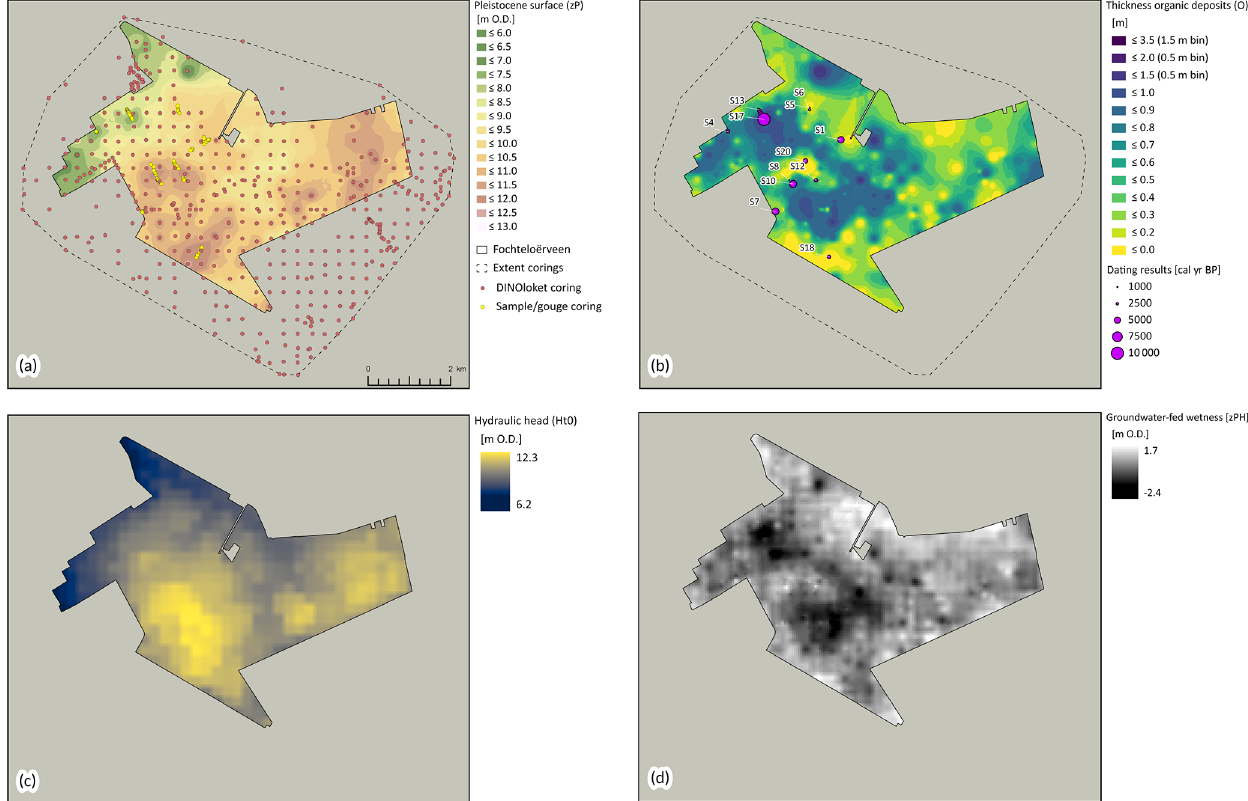
Figure 7. (a) Interpolated elevation of the Pleistocene surface [ z P ] based on data obtained through sample/gouge corings and DINOloket corings (DINOloket – TNO, 2022). (b) Interpolated current thickness of organic deposits [ O ] based on data obtained through sample/gouge corings and DINOloket corings (DINOloket – TNO, 2022). Radiocarbon dates of basal peat samples show peat initiation ages (see Sect. 4.1). (c) Current hydraulic head [ H t ] based on the LHM model (Grondwatertools – TNO, 2022), resampled to 50 × 50m and smoothed through 0 focal statistics. (d) Groundwater-fed wetness that results from geomorphological position, calculated by subtracting the hydraulic head [ H t in (c) from the Pleistocene surface [ z P ] in (a) . For further details on each map, see Sect.